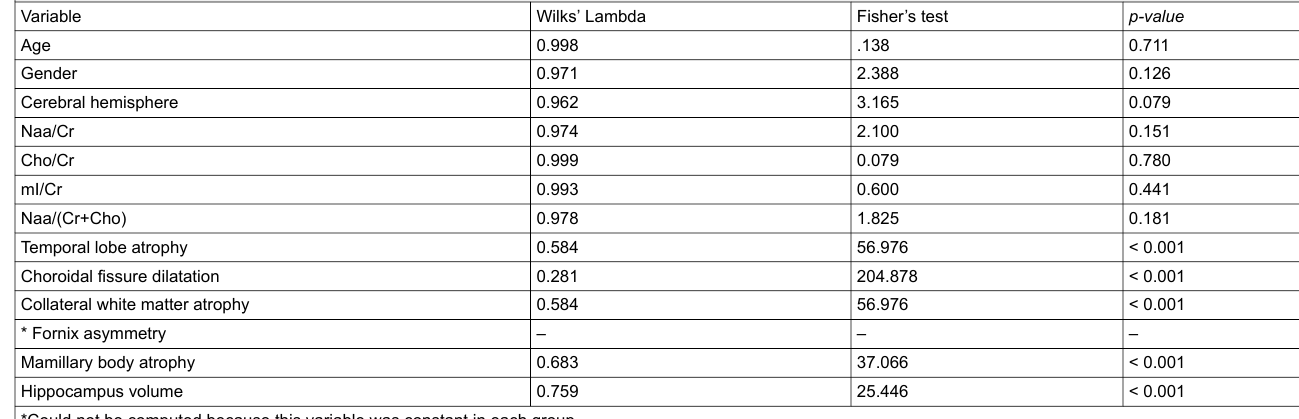
Table 1: Multivariate analysis of secondary MR findings, hippocampal volumetry and spectroscopy shows the statistical differences between means of MTS and non-MTS groups for the independent variables included in the analysis.